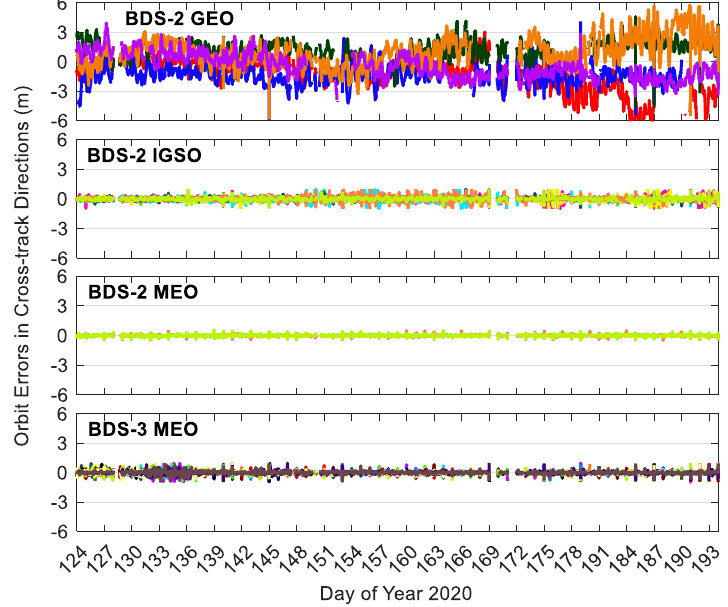
Figure 10. Cross-track errors of BDS-3/BDS-2 precise satellite orbits in the real-time situation. Different colors in the figure refer to different satellites.